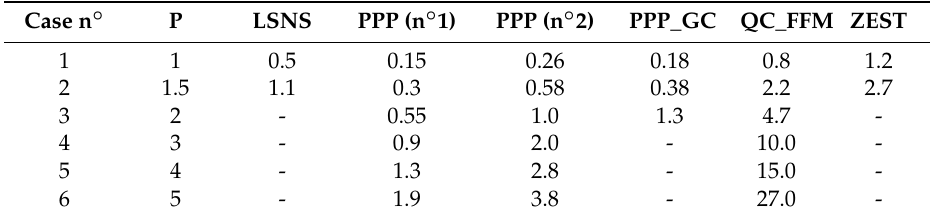
Table 3. The electron densities (in units of 10 15 cm − 3 ) as inferred from the fit of the experimental H- β spectra by the contributing codes. P is the pressure in units of bars.